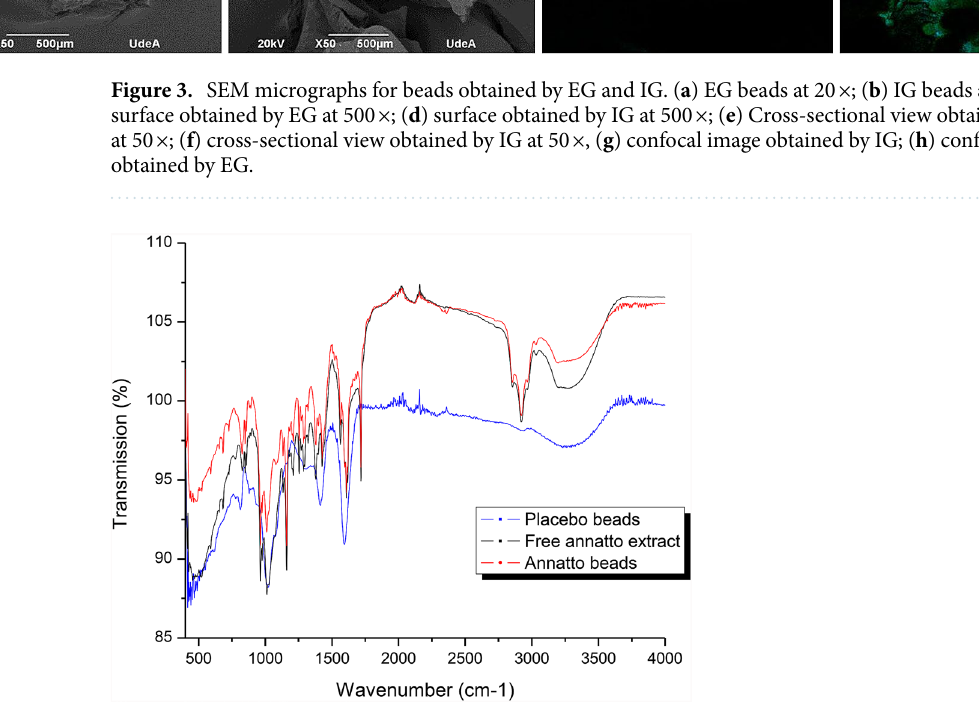
Figure 4. FT-IR spectrum obtained for free annatto extract, encapsulated by EG and blank (beads without extract obtained by